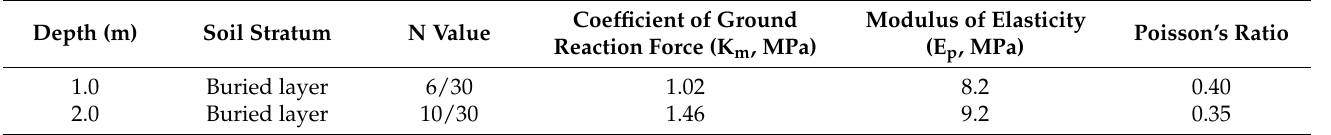
Table 1. Results of lateral load test (borehole test).